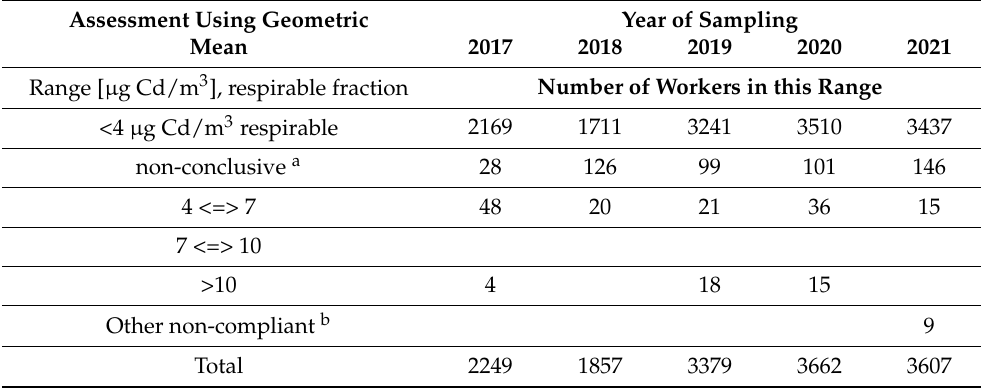
Table 3. ICdA cadmium in air workplace monitoring program “OCdAIR”: numbers of workers compliant ( ≤ 4 µ g Cd/m 3 ) based on geometric mean of measured values per SEG.